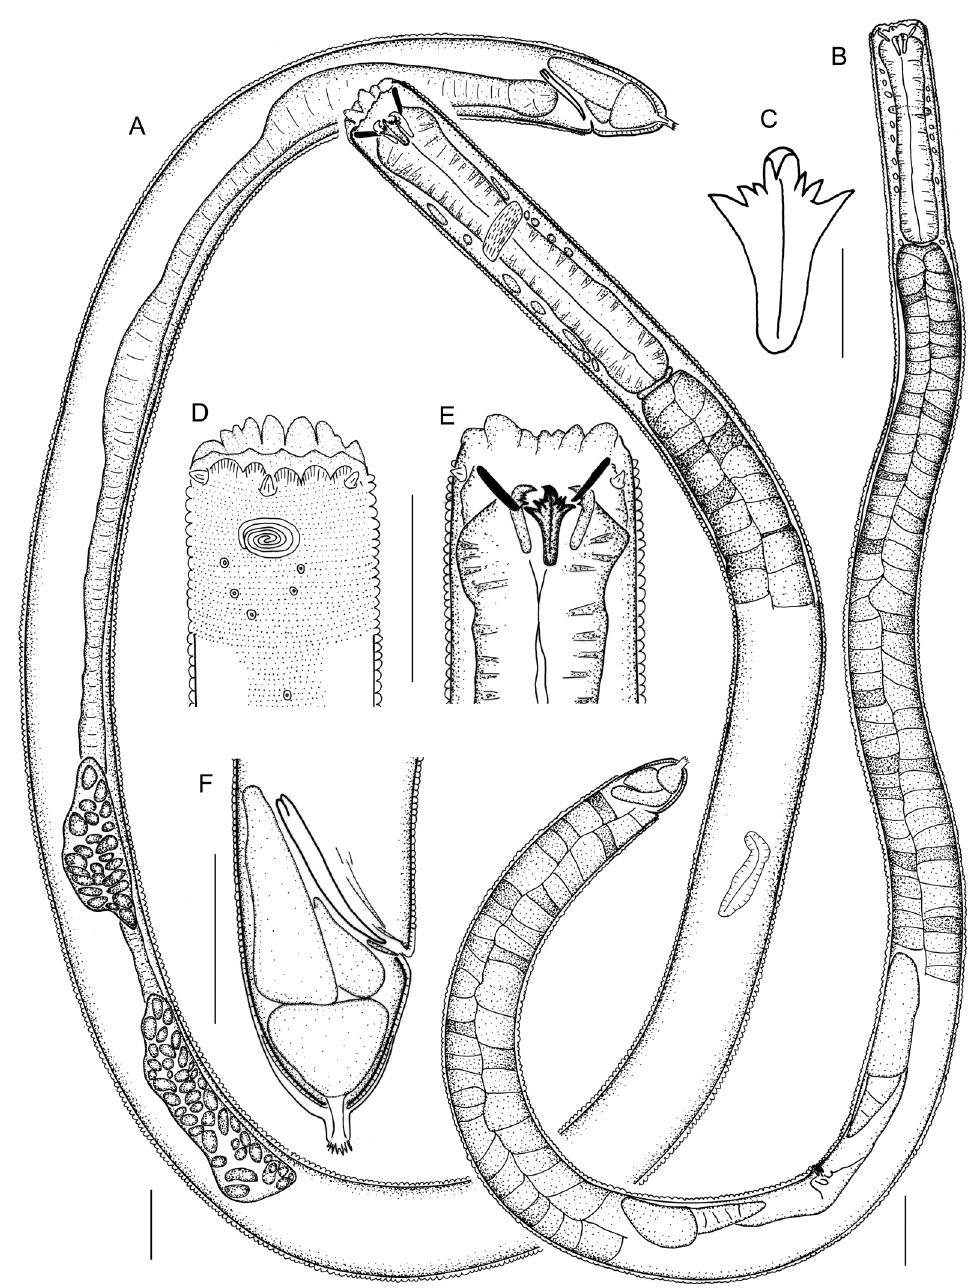
Fig. 5. Synonchium caudatubatum sp. nov., holotype, ♂ (A, C–F) and a paratype, ♀ (B). A . Overview, showing the slightly slender body shape, the broad anterior buccal cavity and the narrow posterior buccal cavity with three mandibles, the cylindrical pharynx with anterior end swelling, the two opposed testes with oval sperm cells, the almost straight spicules without gubernaculum, the caudal glands with spinneret, and the bluntly rounded tail with a protuberant caudal duct. B . Overview, showing same structures as male holotype except the two reflexed ovaries. C . Each mandible has a large tooth flanked by three small teeth to each side. D–E . Head, showing the papillate sensilla, transverse oval amphideal fovea, transverse rows of punctuations, lateral cuticle pores, the broad anterior buccal cavity and the narrow posterior buccal cavity with three mandibles. F . Tail, showing the almost straight spicules without gubernaculum, the three caudal glands with spinneret, and the bluntly rounded tail with protuberant caudal duct. Scale bars: A–B, D–F = 50 μm, C =